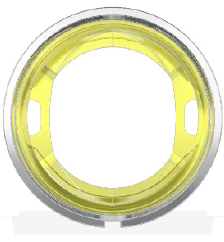
Figure 5. Outflow valve ring with channels improving the leaflets washing.